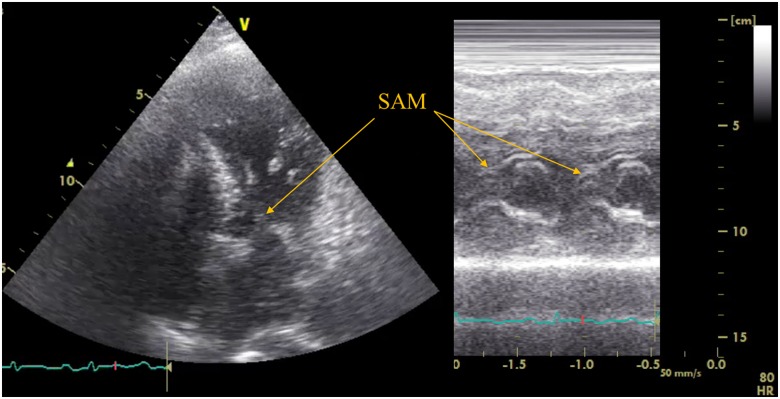
Echocardiography of left ventricular outflow tract obstruction with systolic anterior motion and basal hyperkinesia. LVOT, left ventricular outflow tract; SAM, systolic anterior motion. Note: Apical five chamber view (left) and M-mode of SAM in left parasternal long axis view (right) of echocardiography.